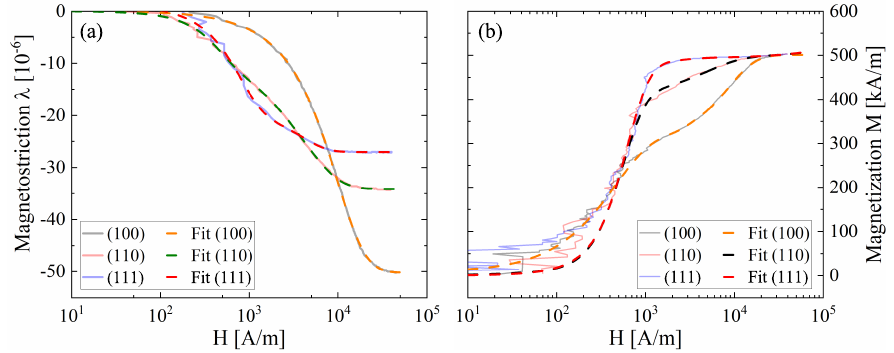
Figure A1. ( a ) Experimental magnetostriction curves of Nickel taken from [29] and their respective fits for the three principal axes. ( b ) Experimental magnetization curves of Nickel taken from [50] and their respective fits with respect to the magnetic field. Table A1. Fit constants for the magnetostriction and magnetization curves according to Equation